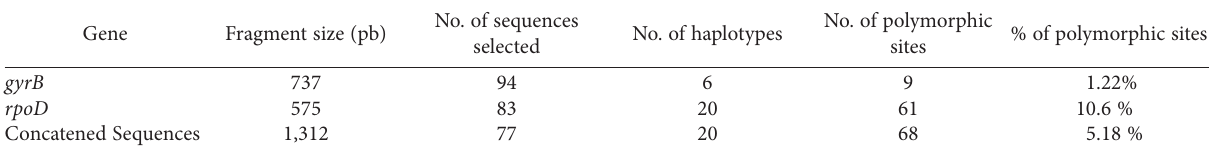
Table 4. Genetic diversity of Xanthomonas campestris pv. campestris isolates assessed by